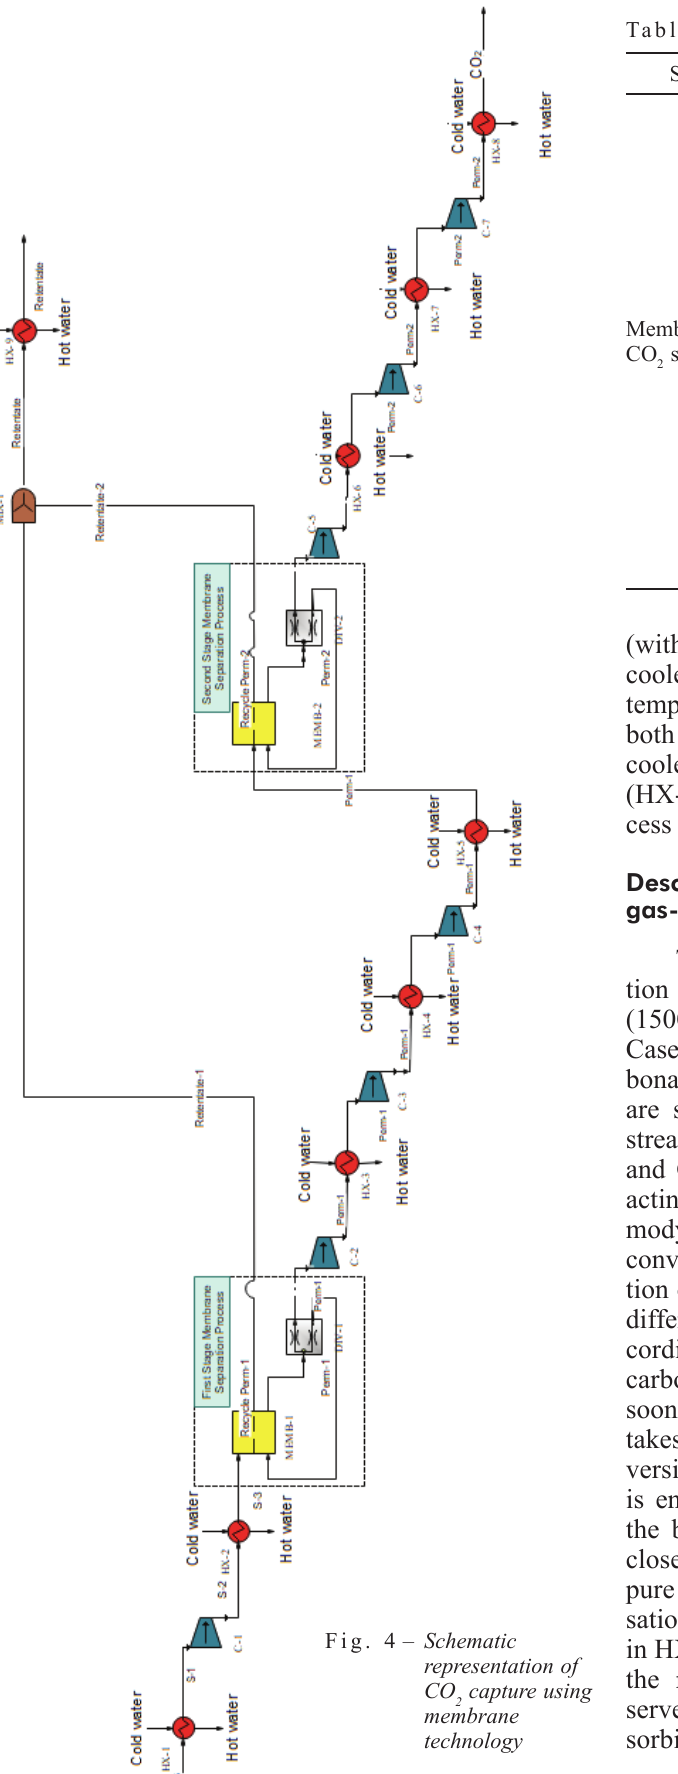
Fig. 4 – Schematic representation of CO capture using 2 membrane